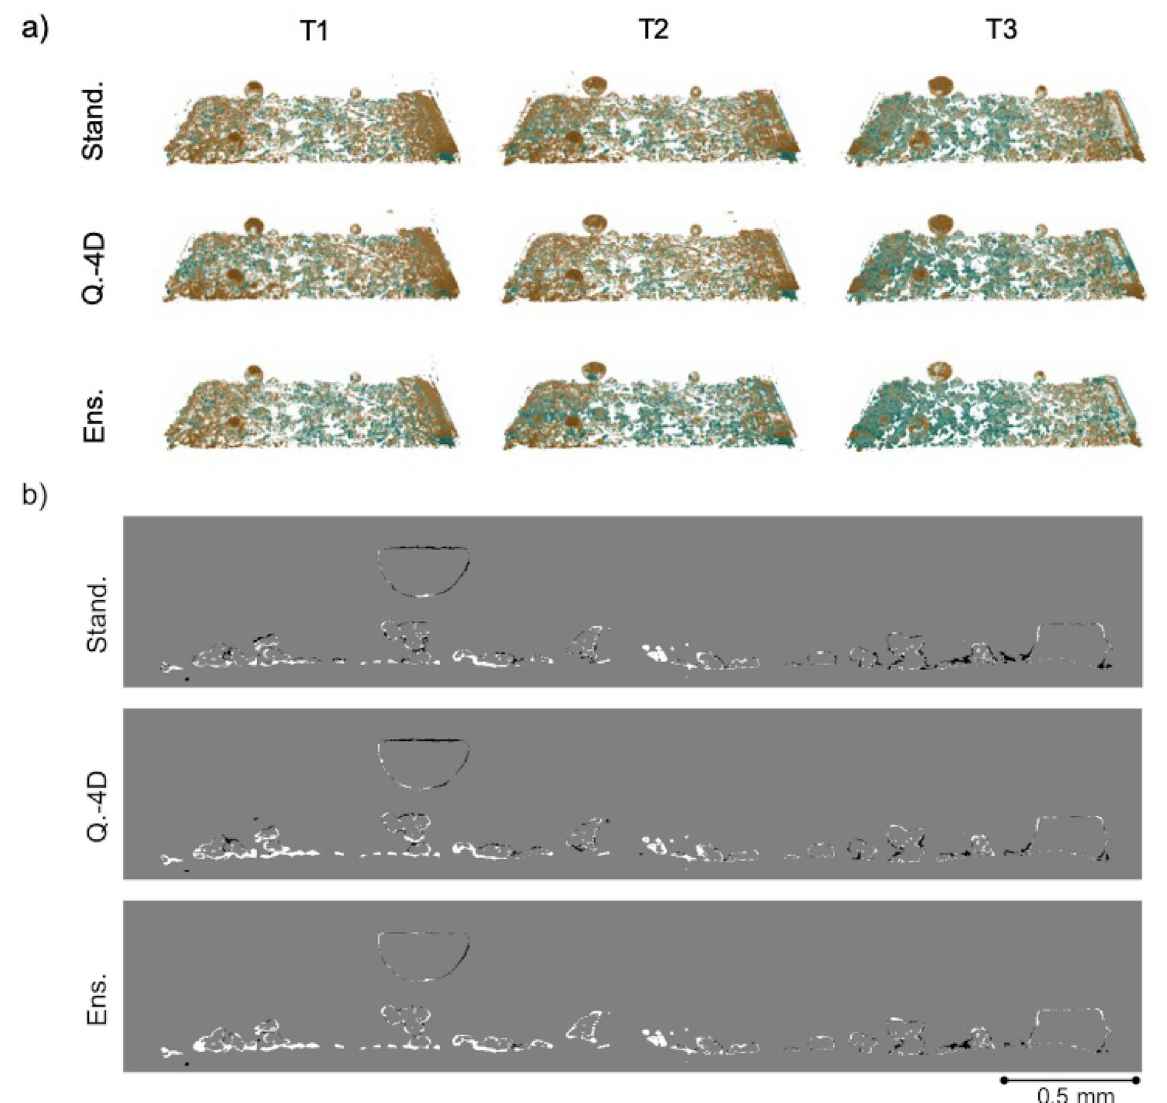
Figure 3. Comparison of the recovered water for the PEFC_1 dataset. The first column presents the first time step (T1), the second column time step 15 (T2) and the third column time step 30 (T3). ( a ) Difference volumes between the manual segmentation (ground truth) and SIRT-FBP-MS-D-DIFF water classifications with standard (Stand.), quasi-4D (Q.-4D) and ensemble (Ens.) training schemes of the MS-D network, respectively. The green color corresponds to features present only in the ground truth, orange to features present only in the SIRT-FBP-MS-D-DIFF water classifications. ( b ) Difference slice (slice 143, T3) between the water classification with the networks and ground truth segmentation. The white structures correspond to features present only in the ground truth segmentation, black structures only in the SIRT-FBP-MS-D-DIFF water